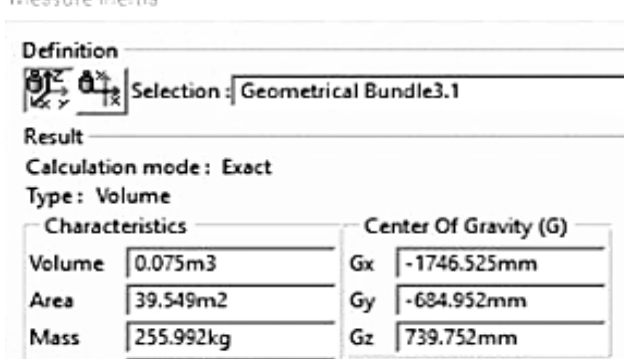
Fig. 13. Centre of gravity of Daihatsu Mira X